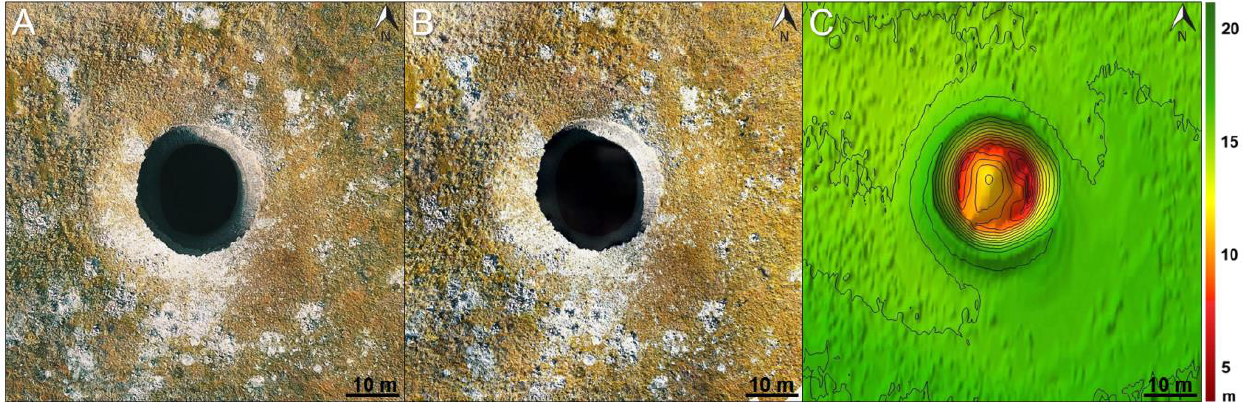
Figure 9. Aerial image from the UAV ( A ), orthophotomap ( B ) and digital elevation model (DEM) in the area of the C17 crater ( C ) (photo by Igor Bogoyavlensky, August 26, 2020).